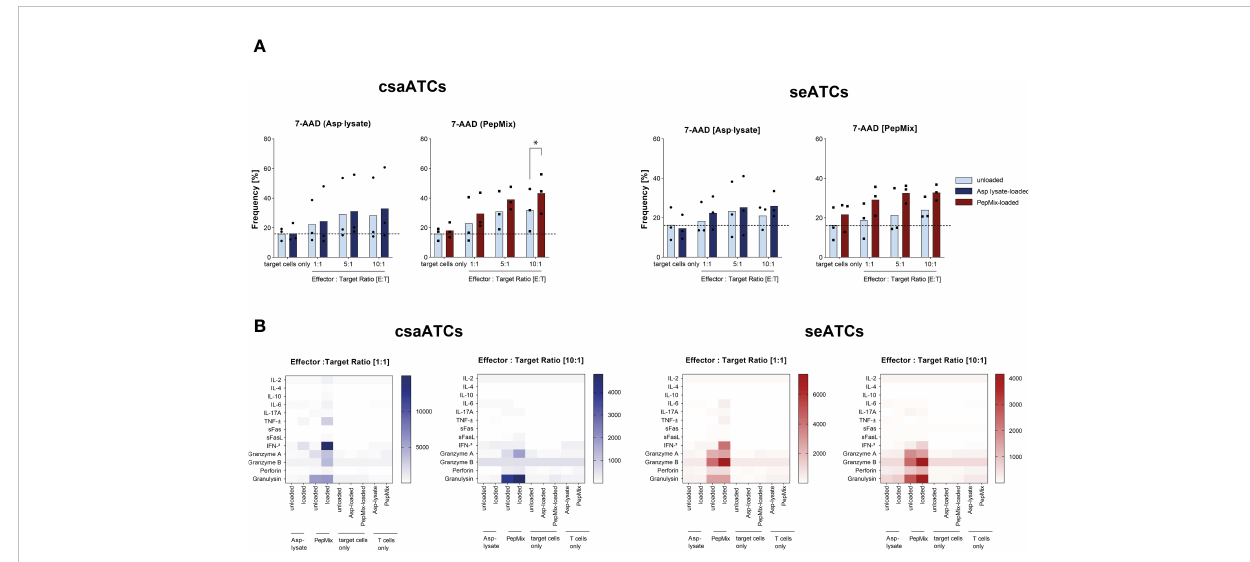
FIGURE 6 Cytotoxic potential of csaATCs and seATCs. Asp-speci fi c T cells obtained by IFN- g Cytokine Secretion Assay (csaATCs) and after short-term expansion (STE) for 12 days (seATCs) were investigated for their cytotoxic functionality. To generate csaATCs and seATCs, PBMCs were stimulated with either the Asp lysate (50 µg/ml) or a combination of eight fungal peptide pools called PepMix (1 µg per peptide/ml per peptide pool consisting of: CatB, Crf1, f22, Gel1, pmp20, SHMT, SOD and MP65 peptide pools). To obtain a suf fi cient number of csaATCs for the analyses, cells were additionally expanded for 12 days. With expanded ATCs, cytotoxicity tests were performed with unloaded and Asp-lysate- or PepMix-loaded autologous PBMCs as target cells. (A) Frequencies of cells with 7-AAD + cells among target cells (CellTrace Proliferation dye positive). Light bars: unloaded target cells. Dark bars: loaded target cells. Results are displayed as individual results and as means (n=3). Statistical signi fi cance was calculated using Two-way ANOVA and multiple comparisons test (*p < 0.05). (B) Cell culture supernatants from cytotoxicity assays from day 12 for effector to target ratios of 1:1 and 10:1were analyzed with respect to presence of cytotoxic effector molecules by LEGENDPlex Assay. Results are displayed as heatmap. The results are expressed as the mean of the duplicates for samples of three tested donors, pre-tested for the presence of Asp-speci fi c T cells (n=3/320). The values are represented by different colors, as referenced in the bar. As control, unloaded, Asp-lysate or PepMix- loaded target cells only as well as Aps-lysate-speci fi c and PepMix-speci fi c T cells only were